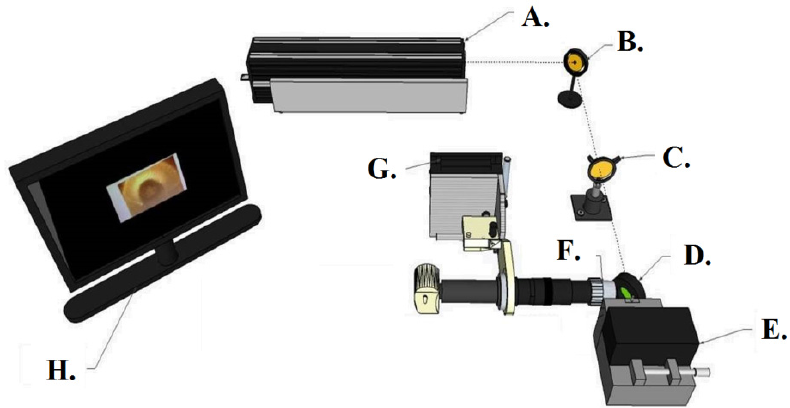
Figure 1. Schematic of the CO 2 laser setup used to produce silica microspheres of approximately 100 µ m diameters. A —CO 2 Laser; B —Mirror; C —Focusing Lens; D —Beam Splitter; E —Sample Stage; F —Microscope; G —Microscope Alignment Block (2-axis Stage); H —Computer.